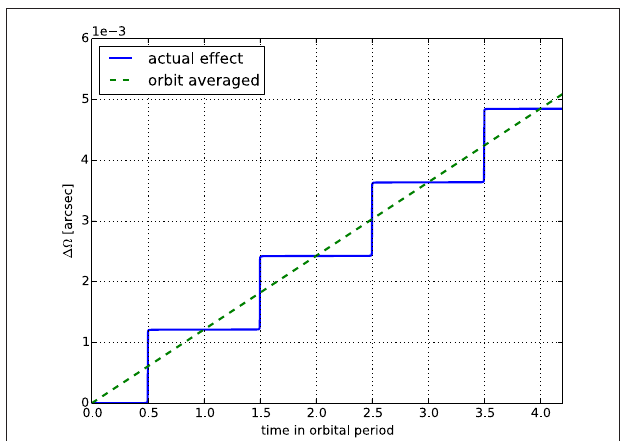
FIGURE 1 | Change of the longitude of the ascending node (cid:127) for a typical Juno orbit due to spin. The solid line shows the actual change of (cid:127) , while the dashed line represents the averaged change given by Equation